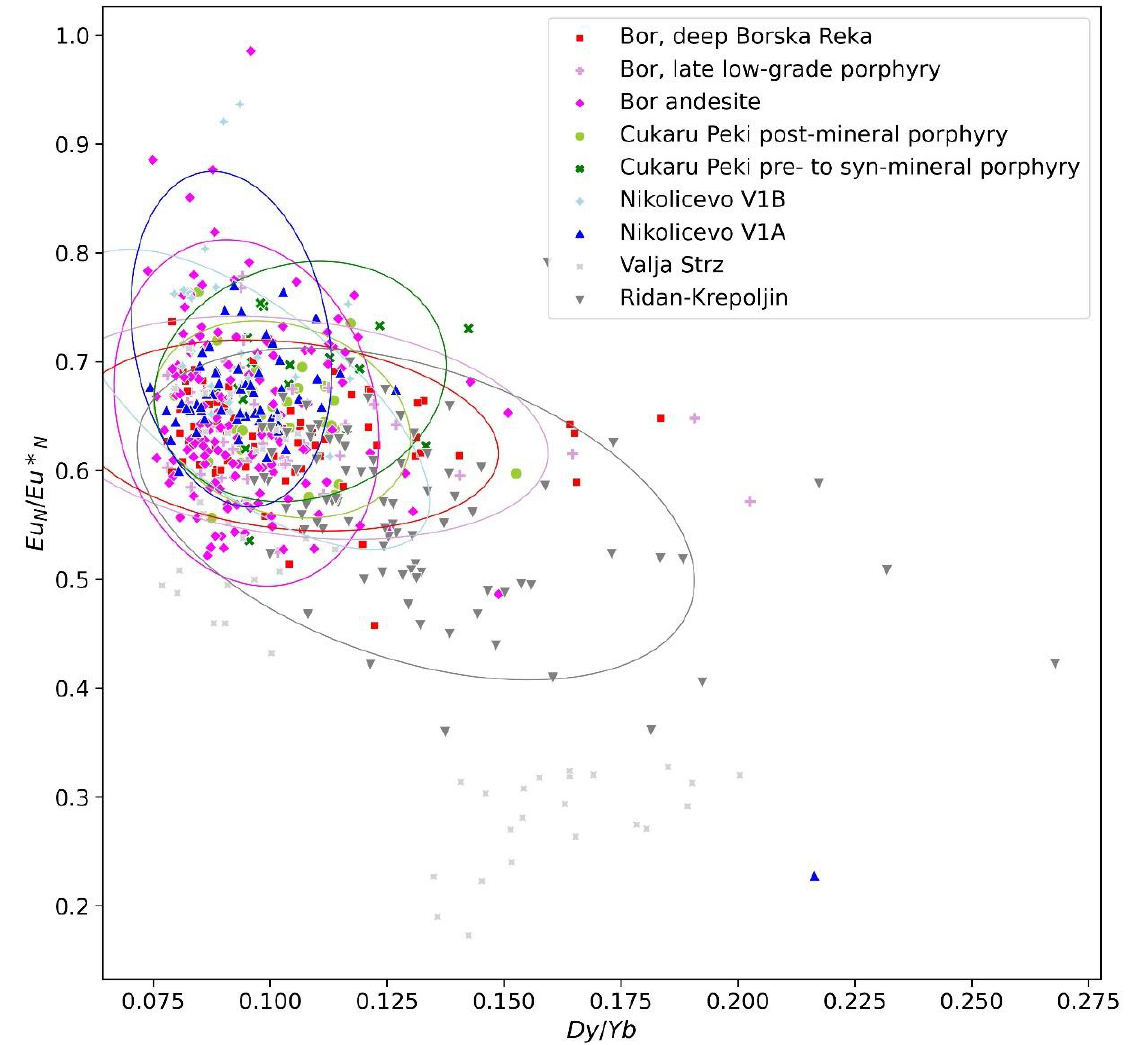
Figure 11. EuN/Eu*N vs. Dy/Yb of zircons, showing somewhat elevated Dy/Yb for weakly mineralized Valja Strz rocks and partial overlap with widely spread values of Dy/Yb of Bor and Cukaru Peki; however, the barren Ridan-Krepoljin signature is clearly different.